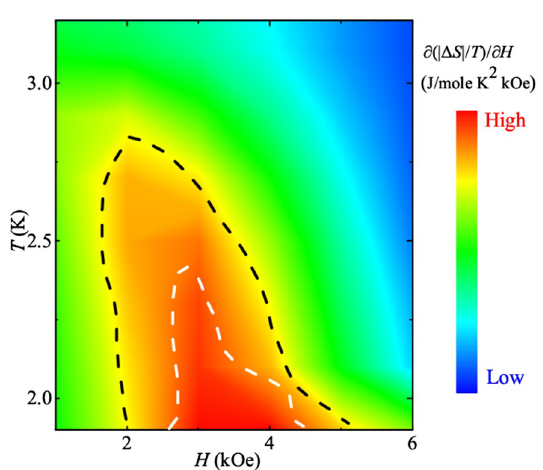
Figure 4. Entropy change (|Δ S |) landscape color map plot derived from MCE data. The white and black dashed curves in the figure separate different